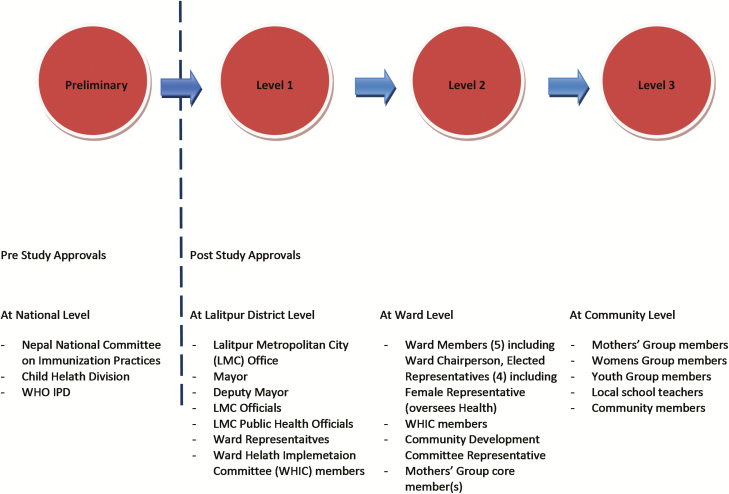
Tiered approach to public engagement in TyVAC-Nepal. Stages required, and groups approached during public engagement in TyVAC-Nepal. Abbreviations: LMC, Lalitpur Metropolitan City; TyVAC, Typhoid Vaccine Acceleration Consortium; WHIC, Ward Health Implementation Committee; WHO IPD, World Health Organization – Immunization Preventable Diseases.